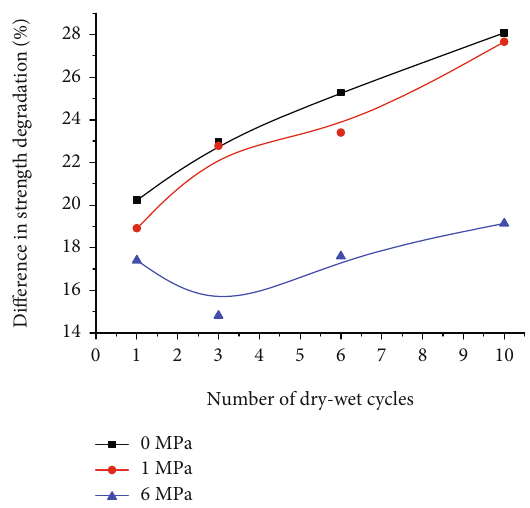
Figure 13: Di ff erence in strength degradation between the saturated state and the dry state under di ff erent wet and dry cycles and con fi ning pressure (after